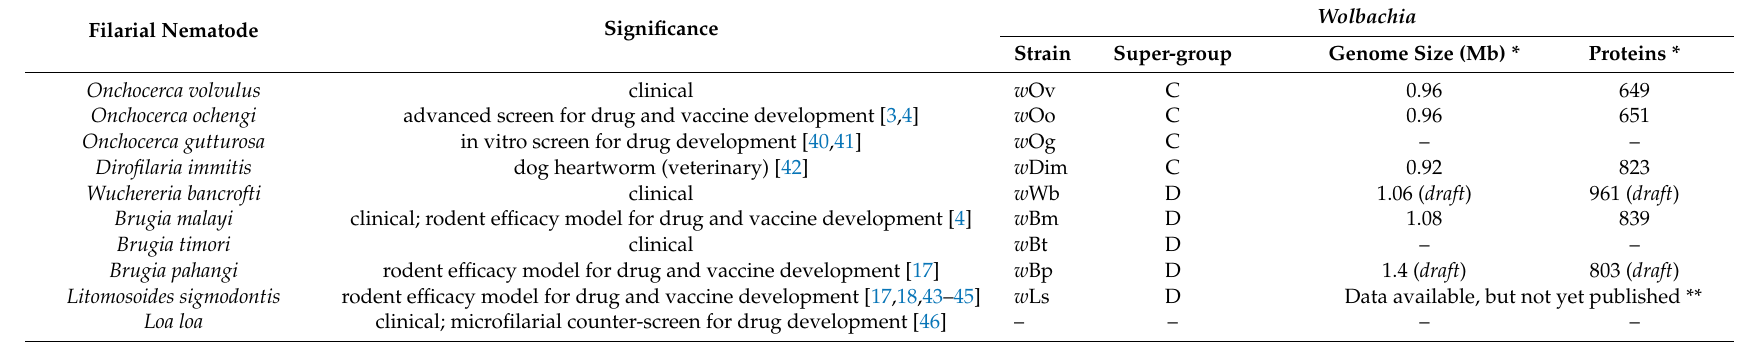
Table 4. Wolbachia strains of filarial nematodes of clinical relevance and ones used for antiwolbachial drug